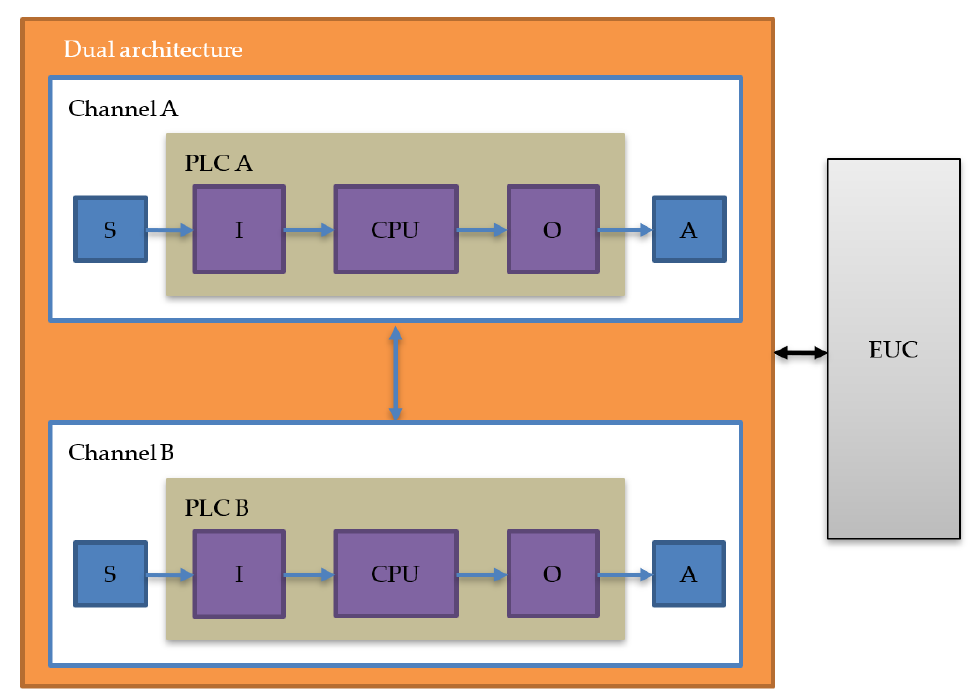
Figure 3. Block diagram of the dual architecture based on sPLC.